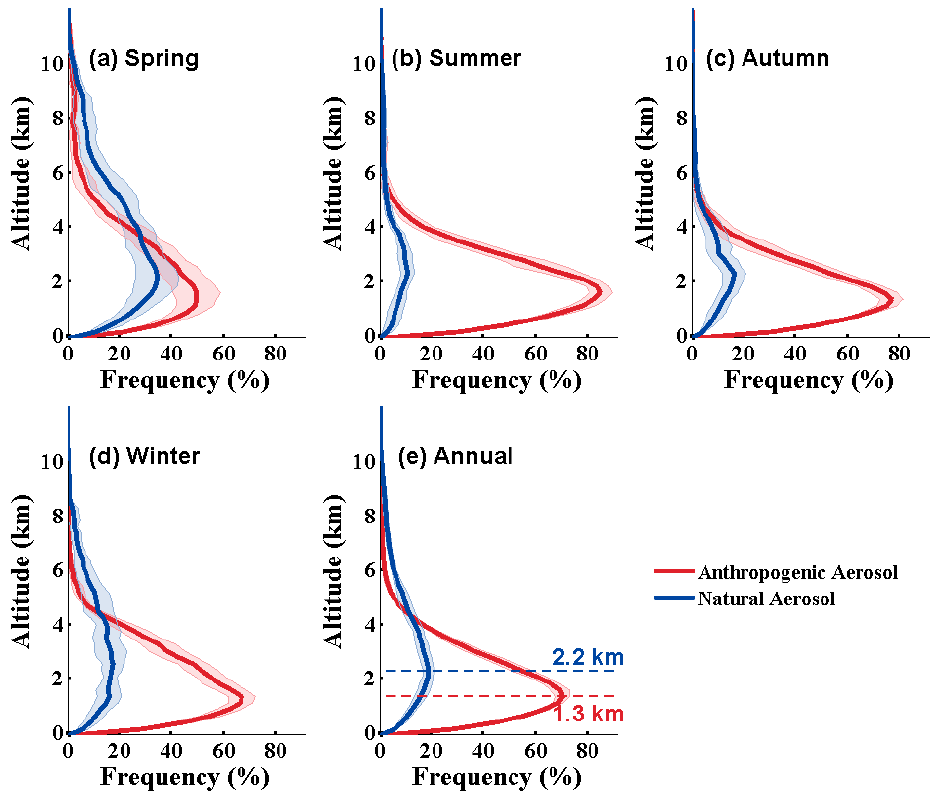
Figure 11. Full-resolution seasonal and annual average occurrence frequencies of anthropogenic aerosols and natural aerosols versus altitude over central China from March 2007 to February 2016. The lightly shaded solid line indicates the inter-annual standard deviation of the vertical distributions of aerosol. The dashed line in Figure 11e indicates the altitude of the largest occurrence frequency (the blue for natural aerosol and the red for anthropogenic aerosol).